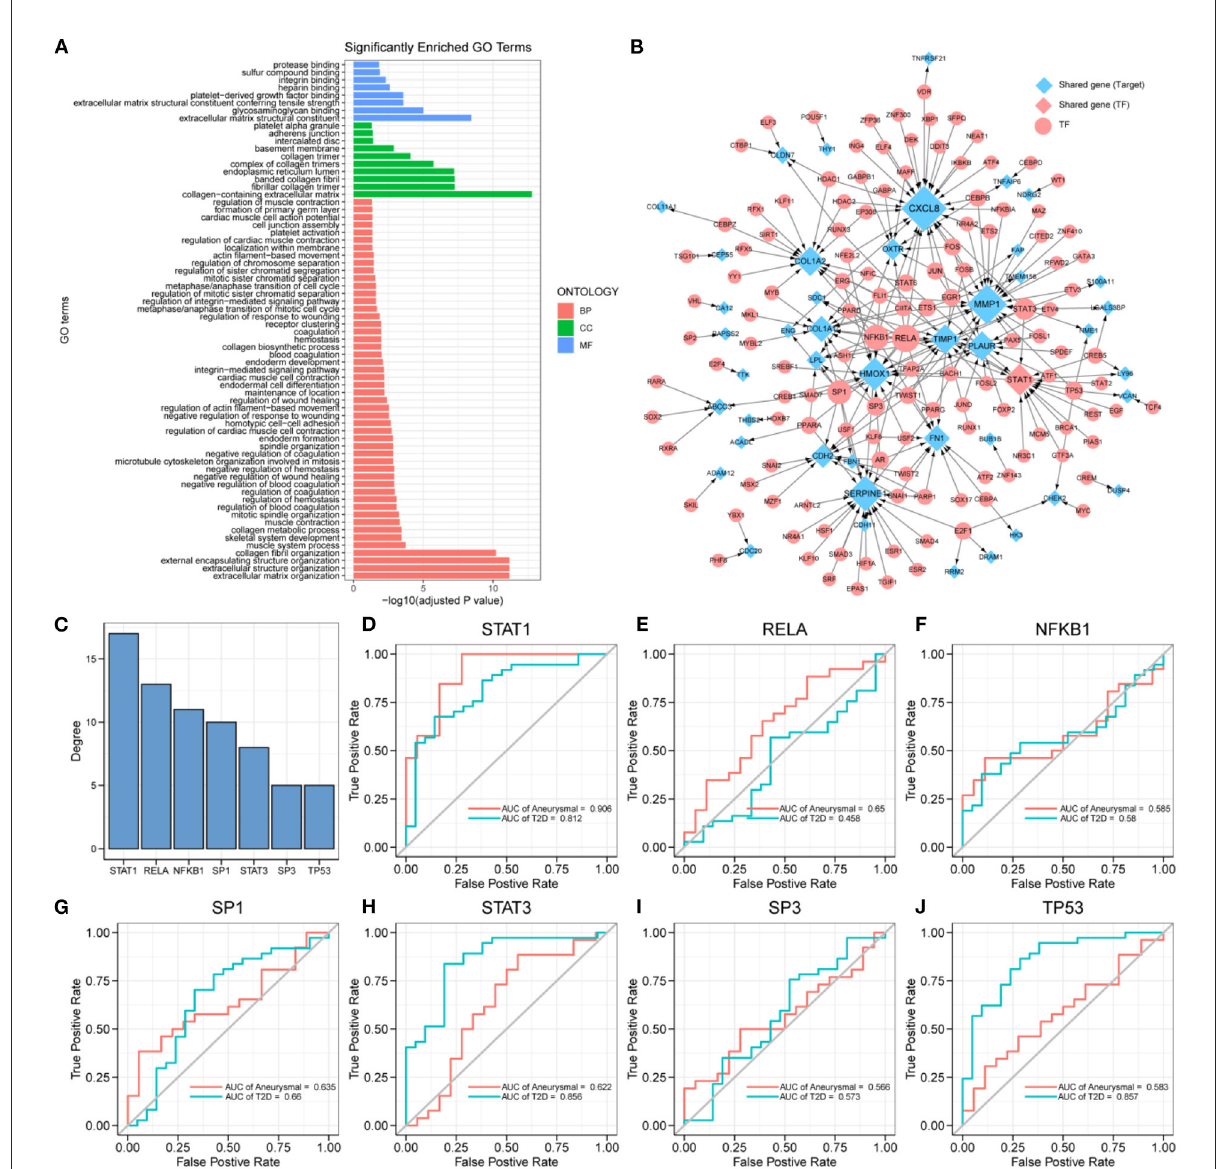
FIGURE3 Key transcription factors associated with the target genes. (A) 216 target genes enriched to gene ontology (GO) pathways, including 8 molecular function (MF) pathways, 10 cellular component (CC) pathways, and 50 biological process (BP) pathways. (B) Transcriptional regulatory networks associated with target genes; the size of nodes is proportional to degree. (C) Transcription factors (TFs) with degree ≥ 5, including: STAT1, RELA, NFKB1, SP1, STAT3, SP3, and TP53. (D–J) ROC curves of STAT1, RELA, NFKB1, SP1, STAT3, SP3, and TP53 in intracranial aneurysm (IA) and type 2 diabetes mellitus (T2DM)